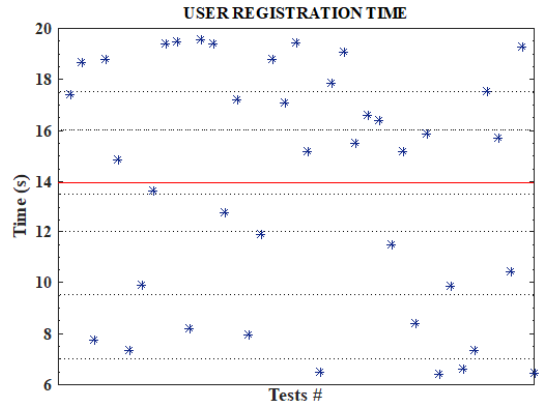
Figure 2. User registration delay.